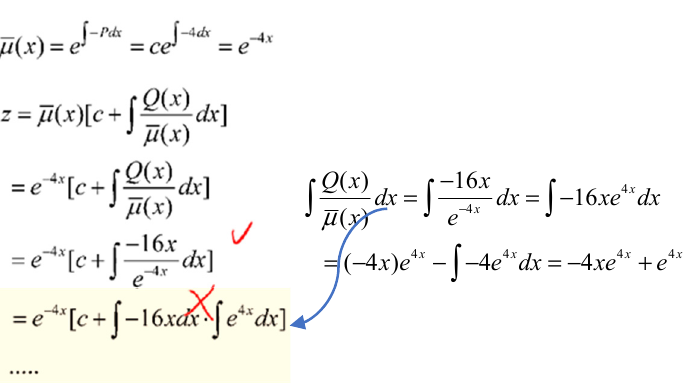
Figure 5. Reproduced example of wrong solution to the assigned ODE using Formula (27).